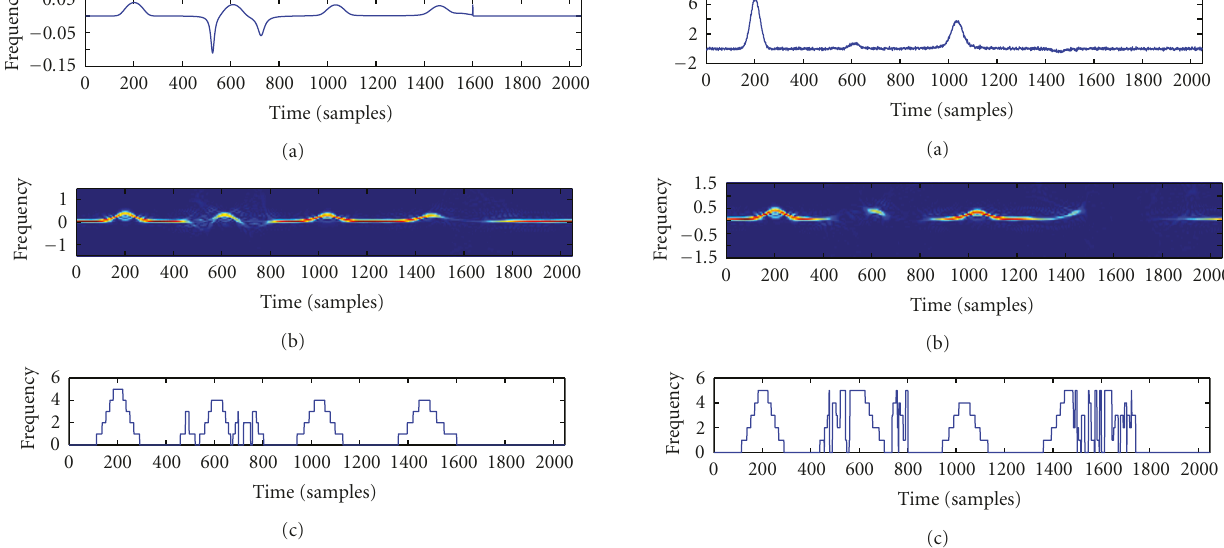
Figure 17: (a) Signal s noised at SNR = 20 db; (b) IFL obtained by GCD; (c) associated detection